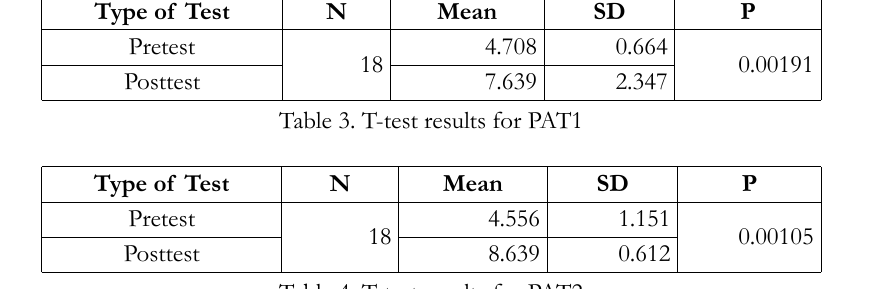
Table 4. T-test results for PAT2